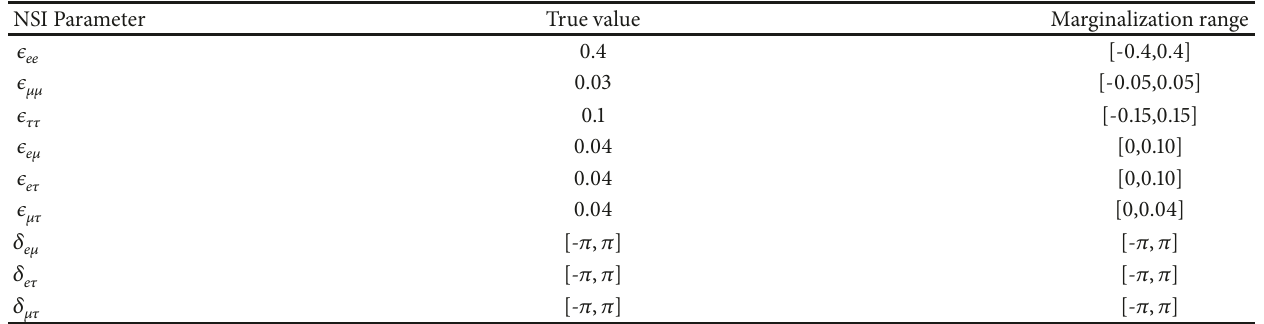
Table 1: The true values and marginalization ranges for all NSI parameters used in the analysis [15,